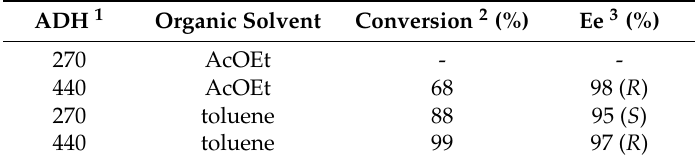
Table 1. ADH-mediated reduction of nitroketone 3a to nitroalcohol 1a in biphasic system a .